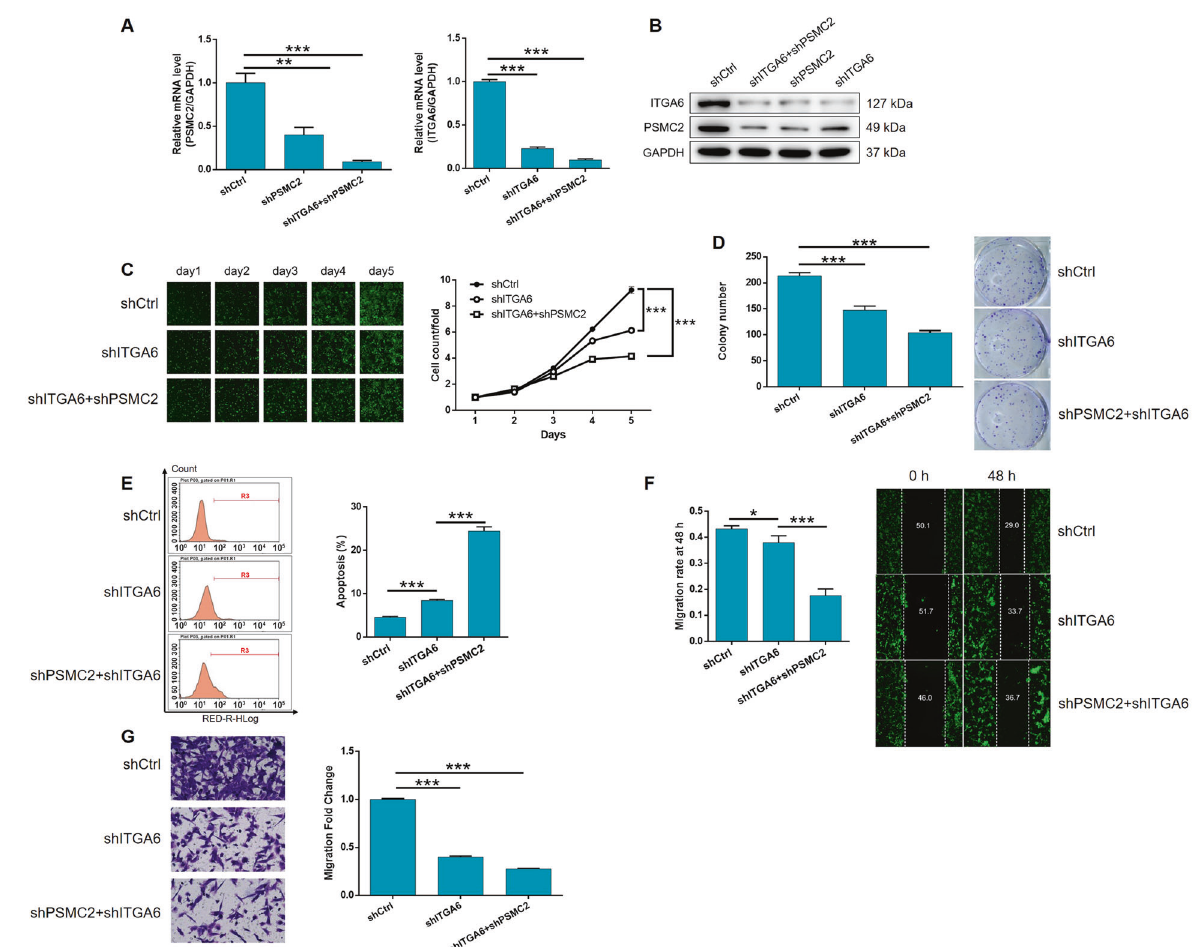
Fig. 4 Knockdown of PSMC2 deepens the effects on HCC cells by ITGA6 knockdown. A , B The expression of PSMC2 and ITGA6 in SK-HEP-1 cells transfected with shCtrl, shITGA6 and simultaneous shPSMC2 and shITGA6 were detected by qPCR ( A ) and western blotting ( B ). Cell models were adopted in the detection of cell proliferation by Celigo cell counting assay ( C ), colony formation ( D ), cell apoptosis ( E ), and cell migration by wound-healing assay ( F ) and Transwell assay ( G ). The representative images were selected from at least three independent experiments. Data were shown as mean ± SD. * P < 0.05, ** P < 0.01, *** P < 0.001. Fig. 5C, D, both tumor volume and weight were signi fi cantly lower in the shPSMC2 group, thus indicating that the absence of PSMC2 led to an inhibition in tumor growth ( P < 0.001). Mechanistic screening Finally, we used western blotting to detect the expression levels of several well-known key molecules in the cancer-associated signaling pathway so that we could investigate the regulatory mechanisms that link PSMC and /ITGA6 with HCC. As indicated by Fig. 5E, the levels of Akt phosphorylation, and the expression levels of CDK6, TLR4, and PIK3CA, were signi fi cantly down- regulated by the knockdown of PSMC2, thus indicating the potential involvement of PSMC2 in the regulation of HCC. DISCUSSION To our best knowledge, the 26S proteasome includes the 20S core catalytic subunit and 19S regulatory subunit, which is one of the multimeric ubiquitin-mediated proteasomes [11, 17]. Accumulat- ing studies provided evidence that proteasome inhibitors played a critical role in anti-tumor with the help of the endoplasmic reticulum stress caused by 26S proteasome inhibition [18]. On the other hand, in view of the multiple important roles played by 26S